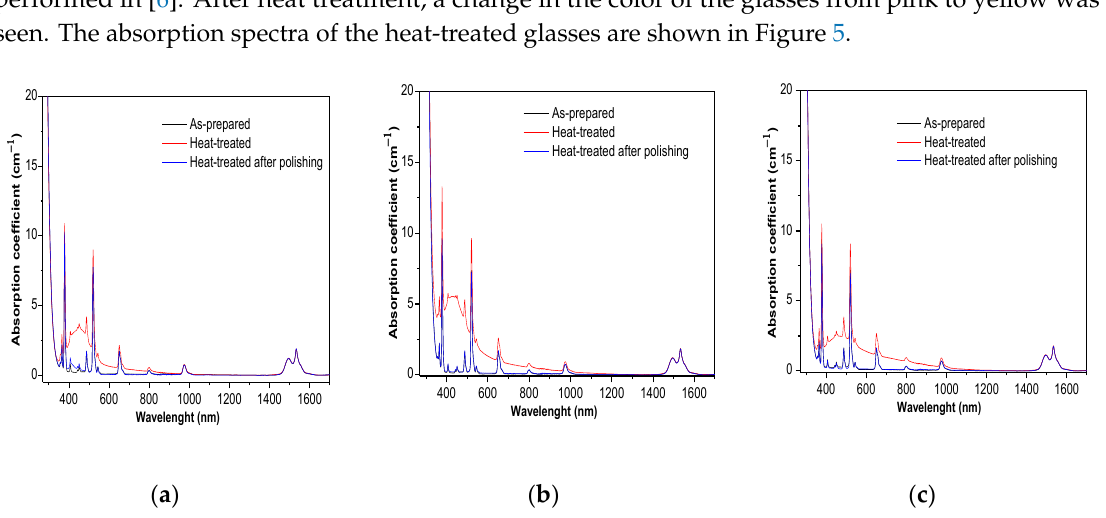
Figure 5. Absorption spectra of the heat-treated glasses: ( a ) Ag2, ( b ) Ag4, and ( c ) Ag6.